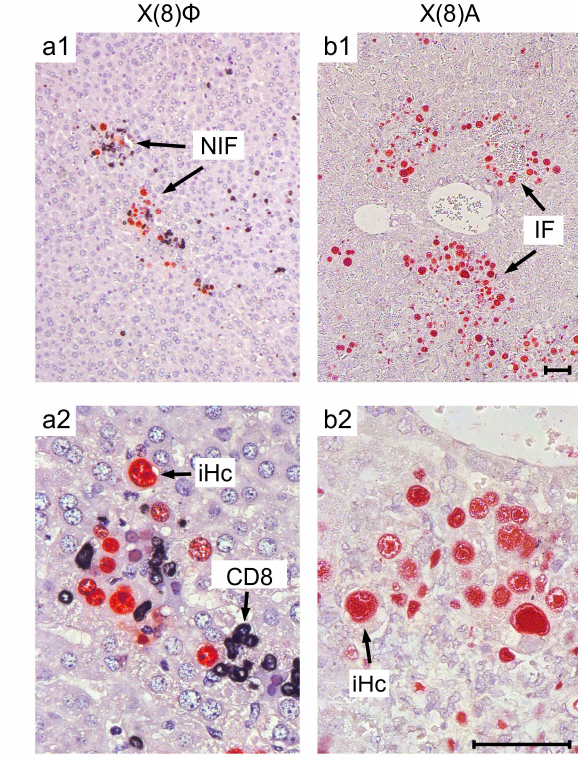
Figure 1. Basic model of immunotherapy of CMV disease. (Left) Experimental protocol. Mice representing designated HCT recipients become immunocompromised by hemato-ablative total-body γ - irradiation (flash symbol), which is followed by infection and by transfer of CD8 + T cells, either CTLLs or cells ex vivo isolated from infected, immunocompetent donor mice, which are both specific for the same viral antigenic peptide (mostly a nonapeptide) with the general sequence X(8) Φ , where X represents amino acid residues and Φ represents the MHC-anchoring C-terminal residue that is mostly a hydrophobic residue. For demonstrating epitope specificity of protection, mice become infected either with parental mCMV encoding the functional antigenic peptide X(8) Φ or with the virus mutant that encodes the nonfunctional sequence X(8)A. The mutation strategy provides dual security, since X(8)A mostly does not even exist as a peptide, because it is usually not generated in the proteasome in the first place. In addition, in case X(8)A is generated, it would fail to anchor to an MHC molecule. (Right) Representative examples of liver histopathology after CD8 + T cell transfer and infection with either parental virus mCMV-X(8) Φ ( a1 , overview, a2 , detail) or mutant virus mCMV-X(8)A ( b1 , overview, b2 detail). Bar markers represent 50 µ m throughout. Immuno-histological staining identifies infected liver cells, which are primarily hepatocytes (iHC, red-stained) as well as tissue-infiltrating CD8 + T cells (CD8, black stained) NIF, nodular inflammatory focus. IF, focus of infection. The representative example is taken from Reference [79], PLOS Pathogens,